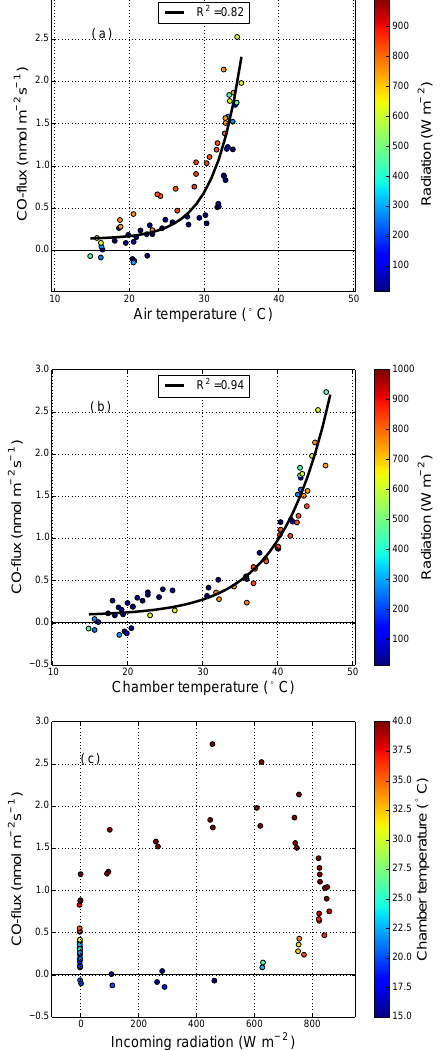
Figure 4. Transparent flux chamber CO fluxes for 15–19 August vs. air temperature (a) , chamber temperature after 6min closure (b) and solar radiation (c) . Regression coefficients of polynomial fits are given in the